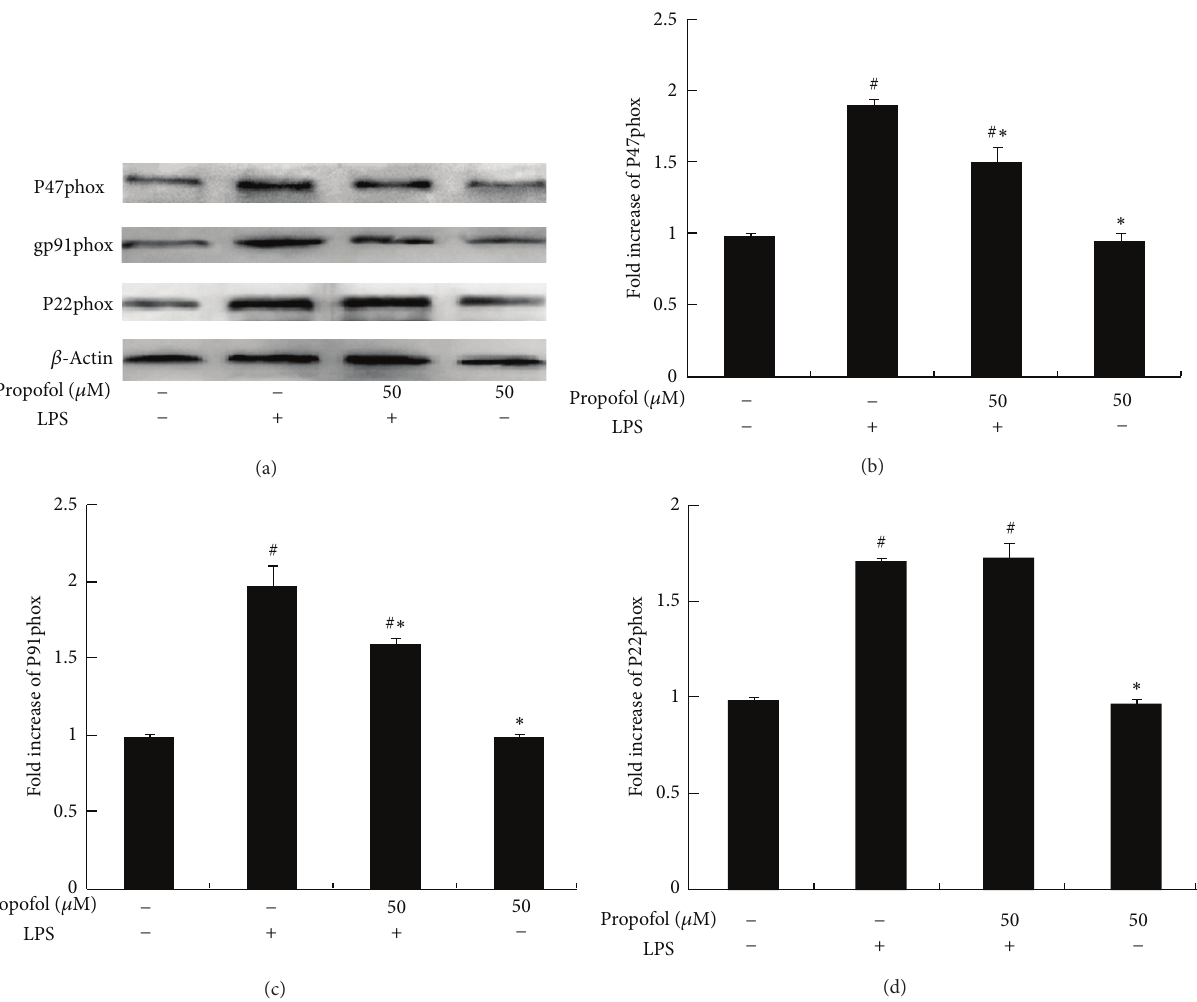
Figure7:EffectofpropofolpretreatmentonLPS-inducedNADPHoxidaseexpression.Cellswerepretreatedwithdimethylsulfoxide(DMSO) or propofol for 40 min and then stimulated with LPS for 8h. (a) Protein expression of oxidase subunits was analyzed by Western blot analysis of whole cell lysates. (b, c, and d) The levels of subunit protein expression were quantified by measuring band intensities and displayed as fold increase relative to 𝛽 -actin. Each value represents the means ± SD for 𝑛 = 4 . # and ∗ indicate that a value significantly ( 𝑃 < 0.05 ) differs from without both propofol and LPS or only LPS treated groups,